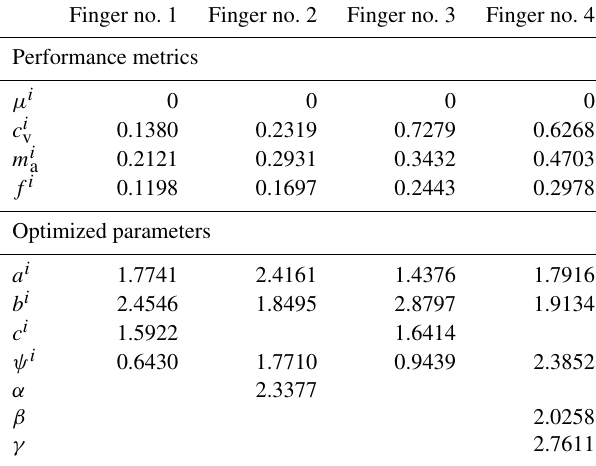
Table 3. Optimization results. Finger no. 1 Finger no. 2 Finger no. 3 Finger no. 4